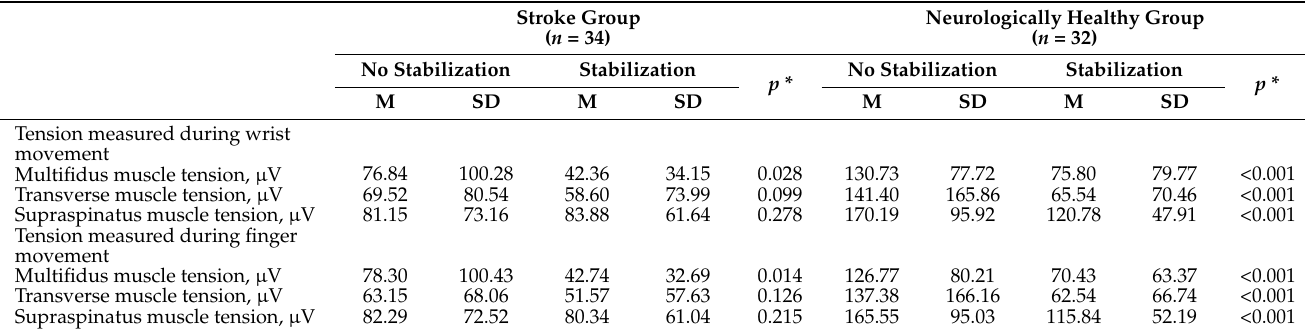
Table 4. Muscle tension parameters measured during wrist or finger movement, with and without stabilization of the trunk and upper limb.